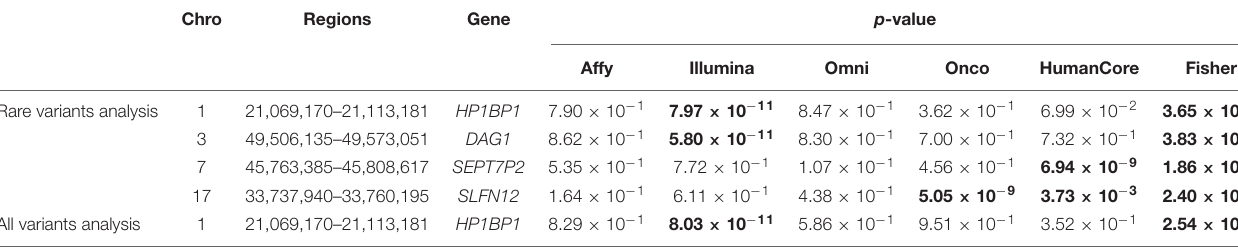
TABLE 4 | Regions identified by Fisher’s combined probability test after Bonferroni adjustment.